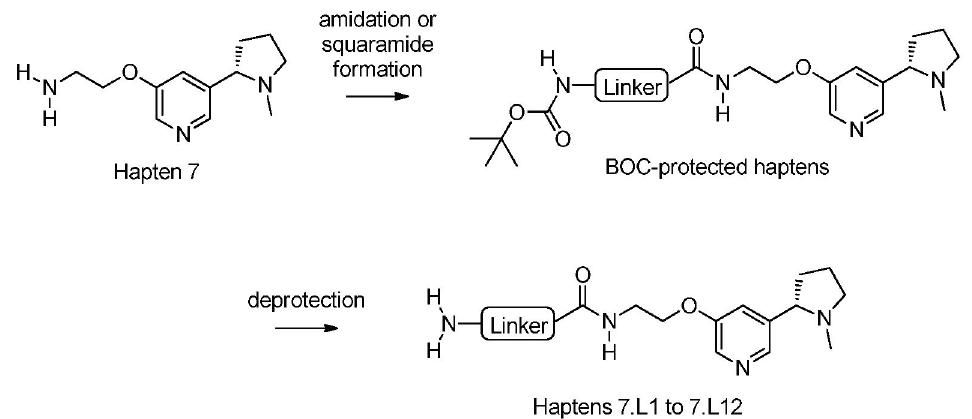
Figure 8. General scheme for addition of different linkers to Hapten 7. doi: